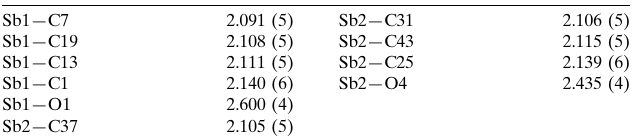
Selected bond lengths (A˚ ).